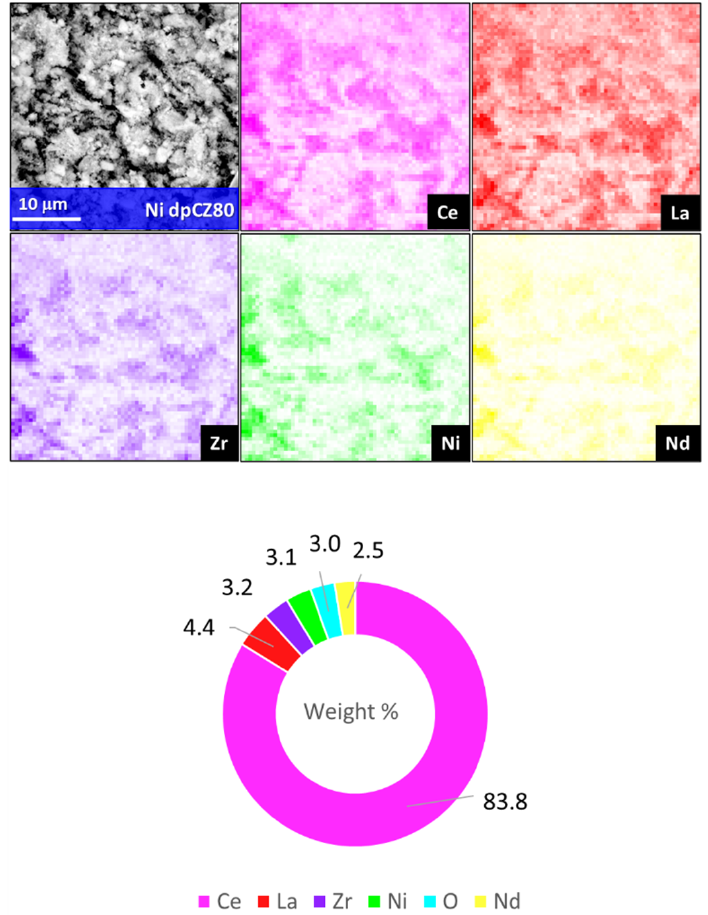
Figure 4. EDX mapping of elements distribution over the NidpCZ80 catalyst.